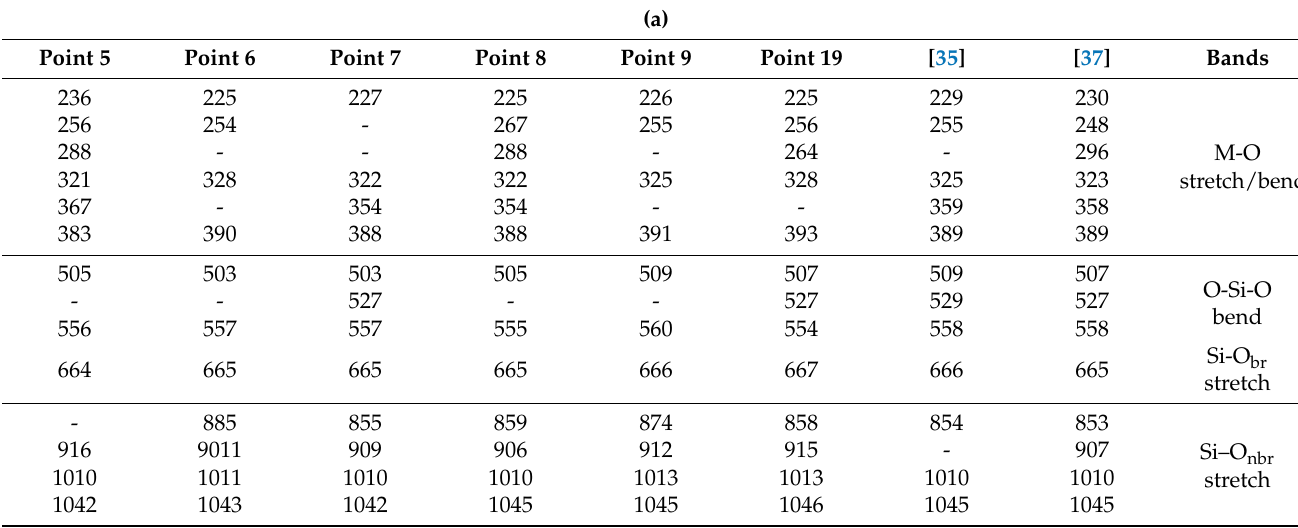
Table 4. Raman frequency (cm − 1 ) of our sample and literature data relative to diopside [35,37] ( a ) and omphacite [37,38] ( b